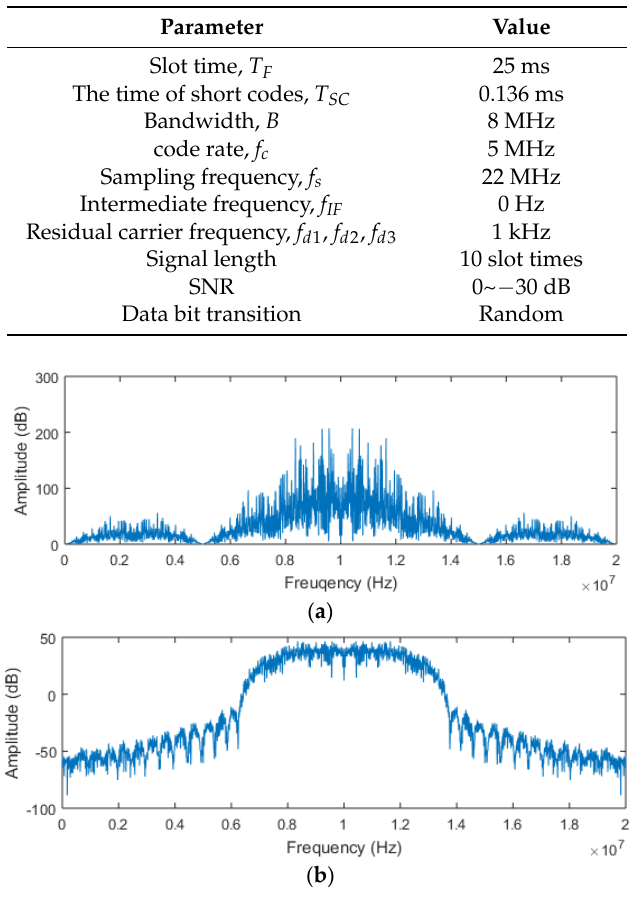
Figure 12. The spectrum of received signals: ( a ) is before filtering and ( b ) is after filtering. Table 1. Simulation parameters.